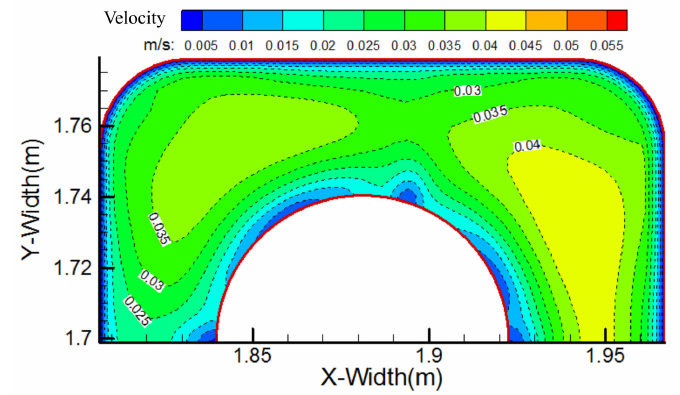
Figure 4. The velocity field of molten steel on the mold surface.